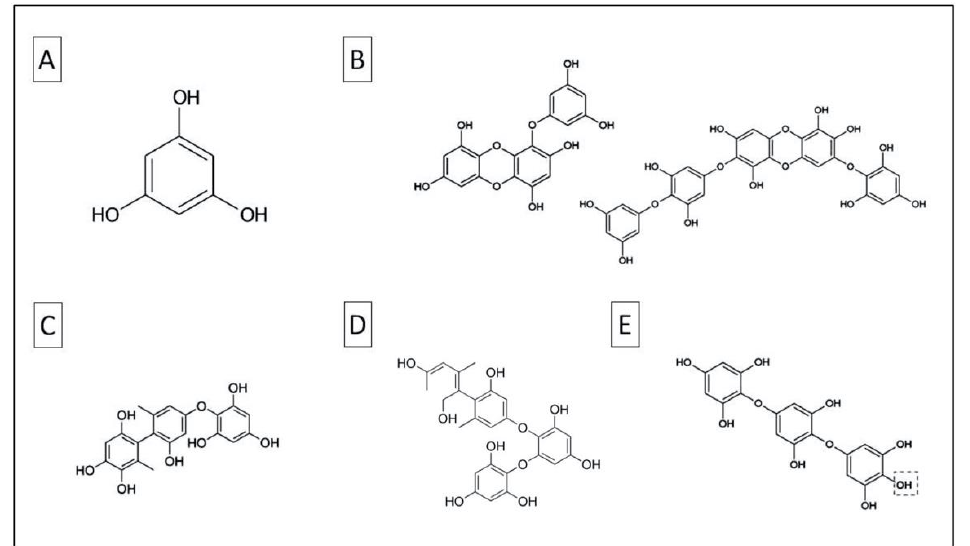
Figure 2. Chemical structures of phloroglucinol (A), eckol (left) and triphlorethohydroxycarmalol (right) (B), fucophloroethol (C), fucodiphloroethol (D), trifuhalol (E) (A, B, E modified from [4]; C, D modified from [71]).